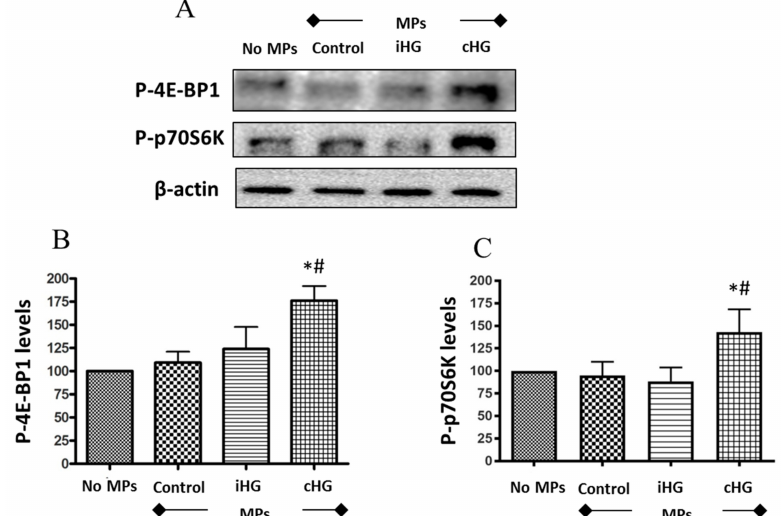
Figure 2. High glucose-derived microparticles (MPs; 10 µ g / mL) induce phosphorylation of two downstream targets of the mammalian target of rapamycin (mTOR) pathway in naïve renal proximal tubular cells. ( A ) Representative Western blots of P-4E-BP1 and P-p70S6K; and ( B , C ) densitometry analyses of P-4E-BP1 and P-p70S6K levels normalized to β -actin respectively. Values were expressed as mean ± SEM; n = 3; * p < 0.05 versus no MPs (control); # p < 0.05 versus control MPs; P-4E-BP1: Phosphorylated-eukaryotic translation initiation factor 4E-binding protein 1; P-p70S6K: Phosphorylated-70kD ribosomal protein S6 kinase; iHG: Intermittent high glucose; cHG: Continuous high